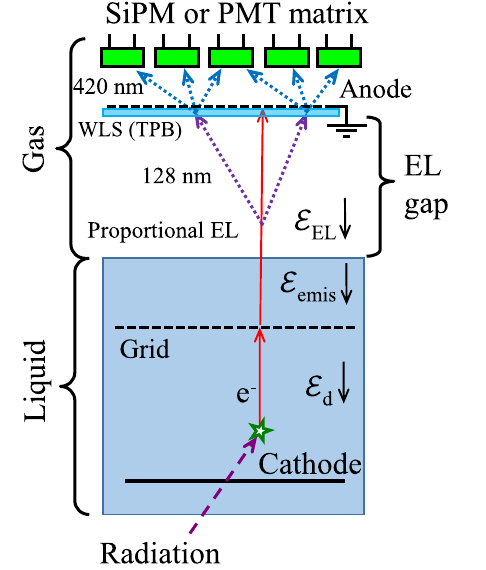
Fig. 3 “Standard”conceptofSiPM-matrixreadoutoftwo-phaseargon detectors with an EL gap